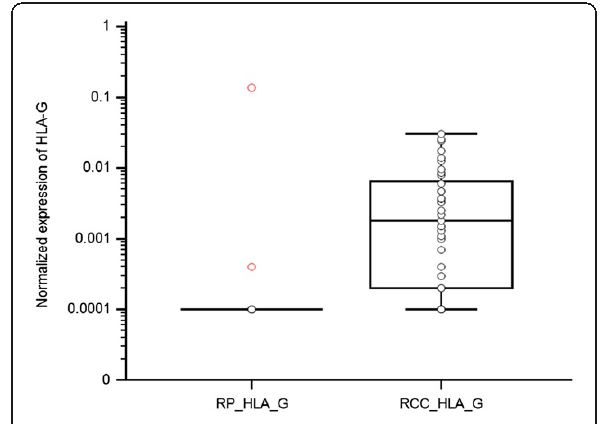
Figure 3 Relapse-free survival of RCC patients based on the HLA-G expression (cut off=75th percentile of HLA-G expression levels in RCC tissue; p=0,0401, Long-rank